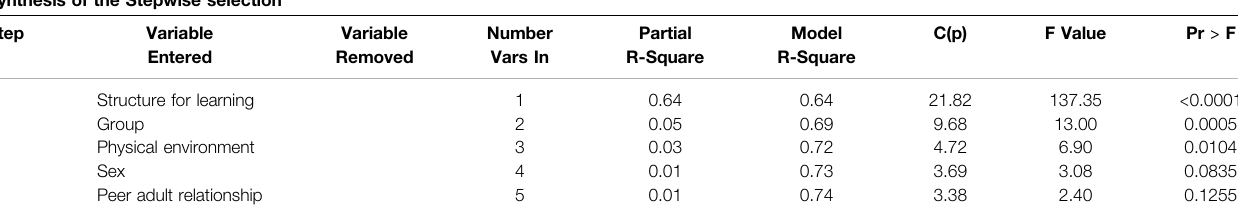
TABLE 7 | Stepwise regression analysis